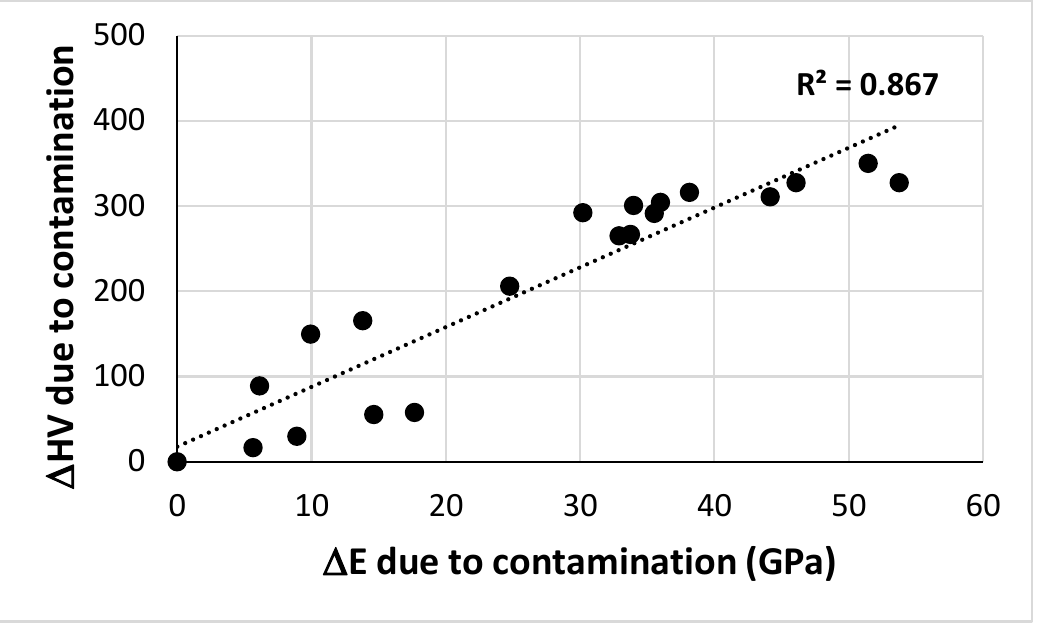
Figure 16. Change in Vickers hardness versus the change in Young’s modulus of the solid solution due to contamination with oxygen. The R 2 value is for the linear fit of all data.